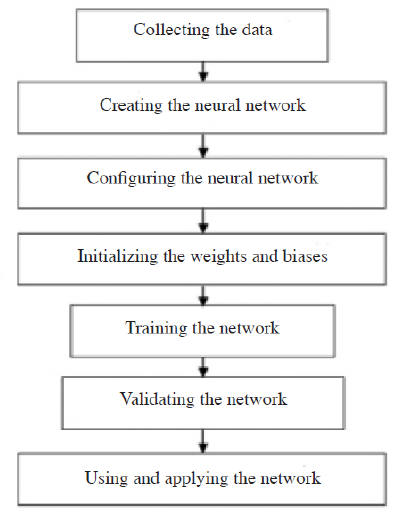
Figure 2. Design steps of Neural Networks.